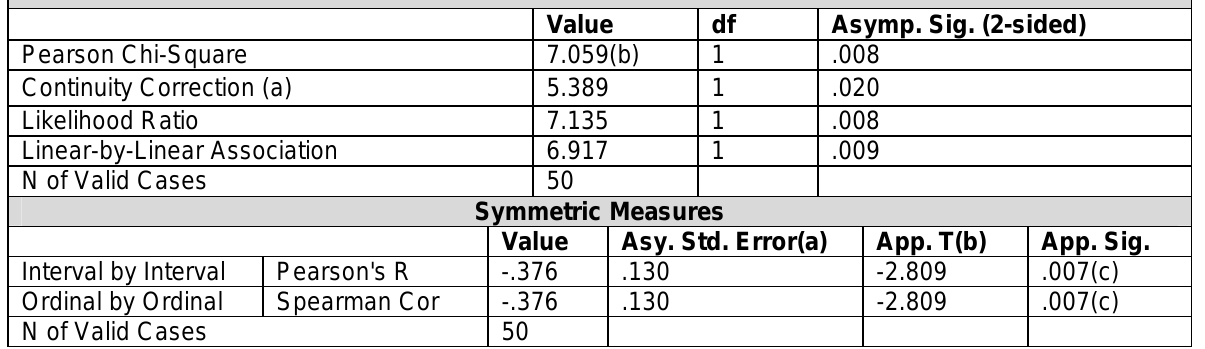
Table 3: Gender and unfair career advancement opportunities in the nursing field Chi-Square Tests: Gender and unfair Career Advancement Opportunities in the Nursing